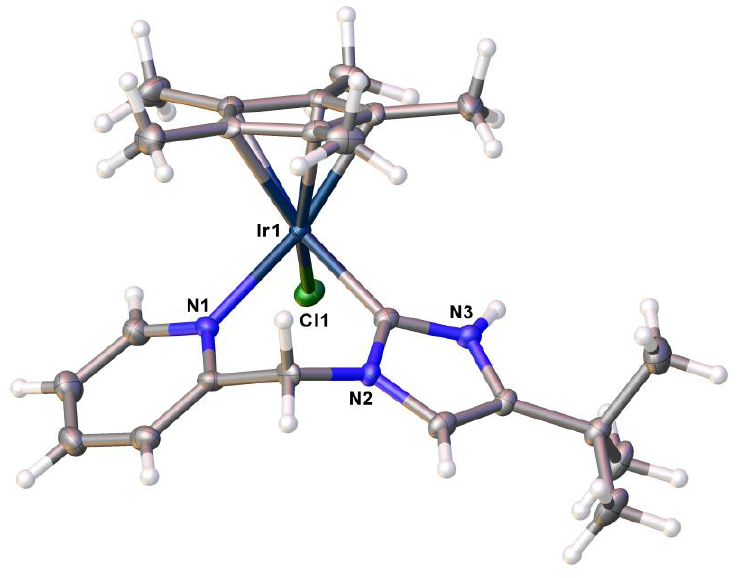
Figure 2. Crystal structure of the cation of 9b-Ir ; PF 6 − anion and two THF molecules are excluded for clarity.